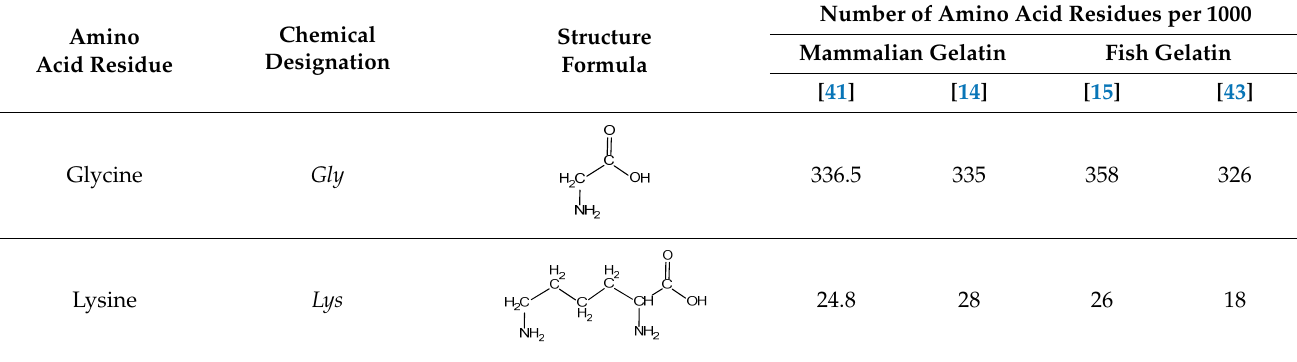
Table 1. Amino acid composition of gelatin.